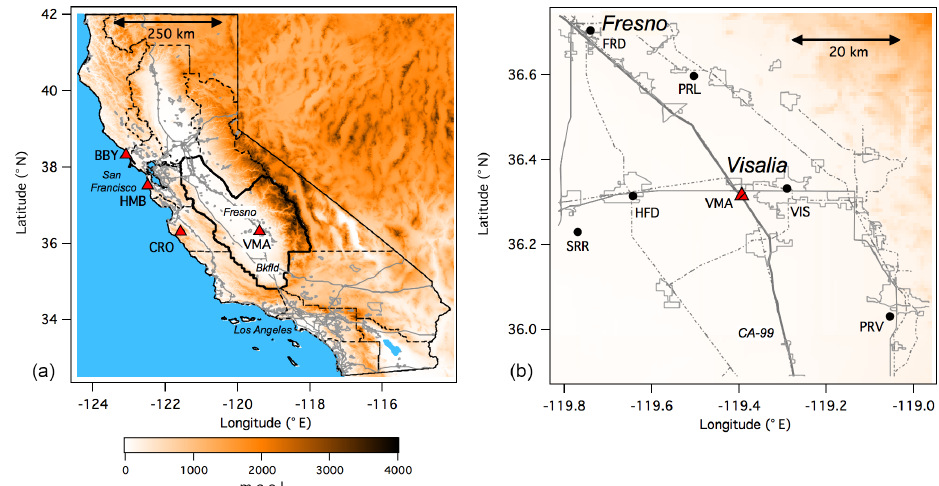
Figure 1. (a) Topographic map showing the air basins of California (dashed black lines); the San Joaquin Valley Air Basin (SJVAB) is outlined in heavy solid black. Interstate highways and urban areas are shown in gray. The filled red triangles show the CABOTS measurement sites at Bodega Bay (BBY), Half Moon Bay (HMB), Visalia Municipal Airport (VMA), and Chews Ridge Observatory (CRO). (b) The same as (a) but showing an enlarged view of the area surrounding the VMA. The solid and dotted–dashed gray lines represent the major highways and railroads, respectively, with the heavier solid line showing CA-99 (see text). The filled black squares show the six closest regulatory O 3 monitors active during the CABOTS campaign: Visalia (VIS), Hanford (HFD), Santa Rosa Rancheria (SRR), Fresno–Drummond St. (FRD), Parlier (PRL), and Porterville (PRV). The elevation scale is the same as in (a) .